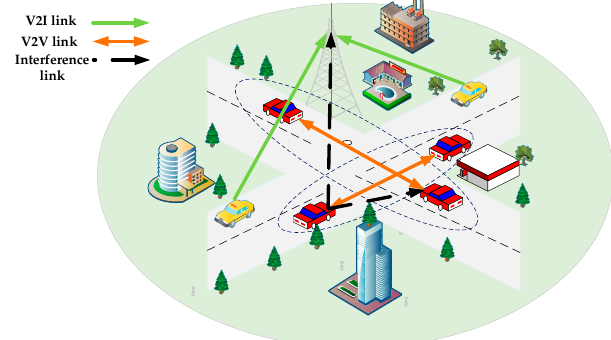
Figure 1. V2X communication scenarios.